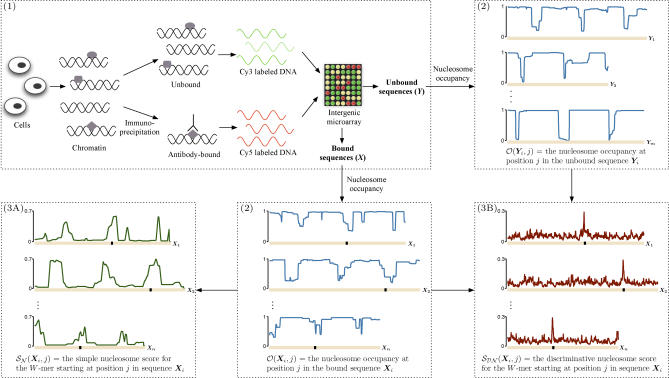
Steps in the Derivation of the Nucleosome Scores S℘N℘ and S℘D℘N℘
(1) Obtain the sets of bound and unbound sequences ({X
1,X
2,…,X
n) and {Y
1,Y
2,…,Y
m}, respectively) from a ChIP-chip experiment for a particular TF ((inidcated by a diamond).(2) Determine the nucleosome occupancy O℘ for all the bound and the unbound sequences.(3A) Compute the simple nucleosome score S℘N℘(X
i, j) for each W-mer starting at position j in the bound sequence X
i by averaging the accessibility (1 − O℘) over all positions in the W-mer.(3B) Compute the discriminative nucleosome score S℘D℘
N℘(X
i, j) for each W-mer starting at position j in sequence X
i, using the accessibility (1 − O℘) over all occurrences of this W-mer in both the bound and the unbound sequences (see Materials and Methods for details). All the sequences and scores depicted in this figure correspond to the TF Reb1 profiled in YPD and use occupancy predictions from the computational model of Segal et al. The black boxes on the bound DNA sequences indicate matches to the Reb1 motif.